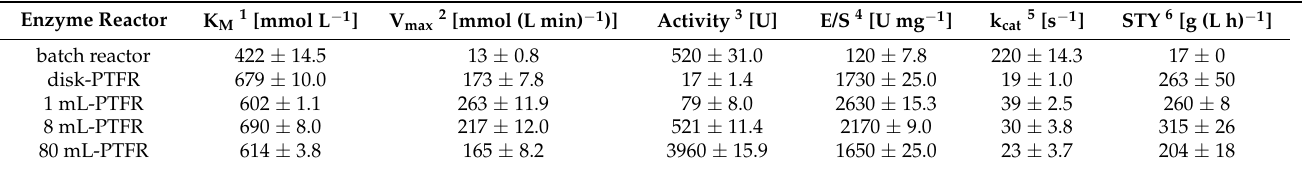
Table 2. Kinetic parameters, activities, enzyme-substrate-ratio (E/S), turn-over-number (k cat ) and space-time-yield STY of free and on PTFR immobilized enzyme, determined with semi-continuous configuration (Figure